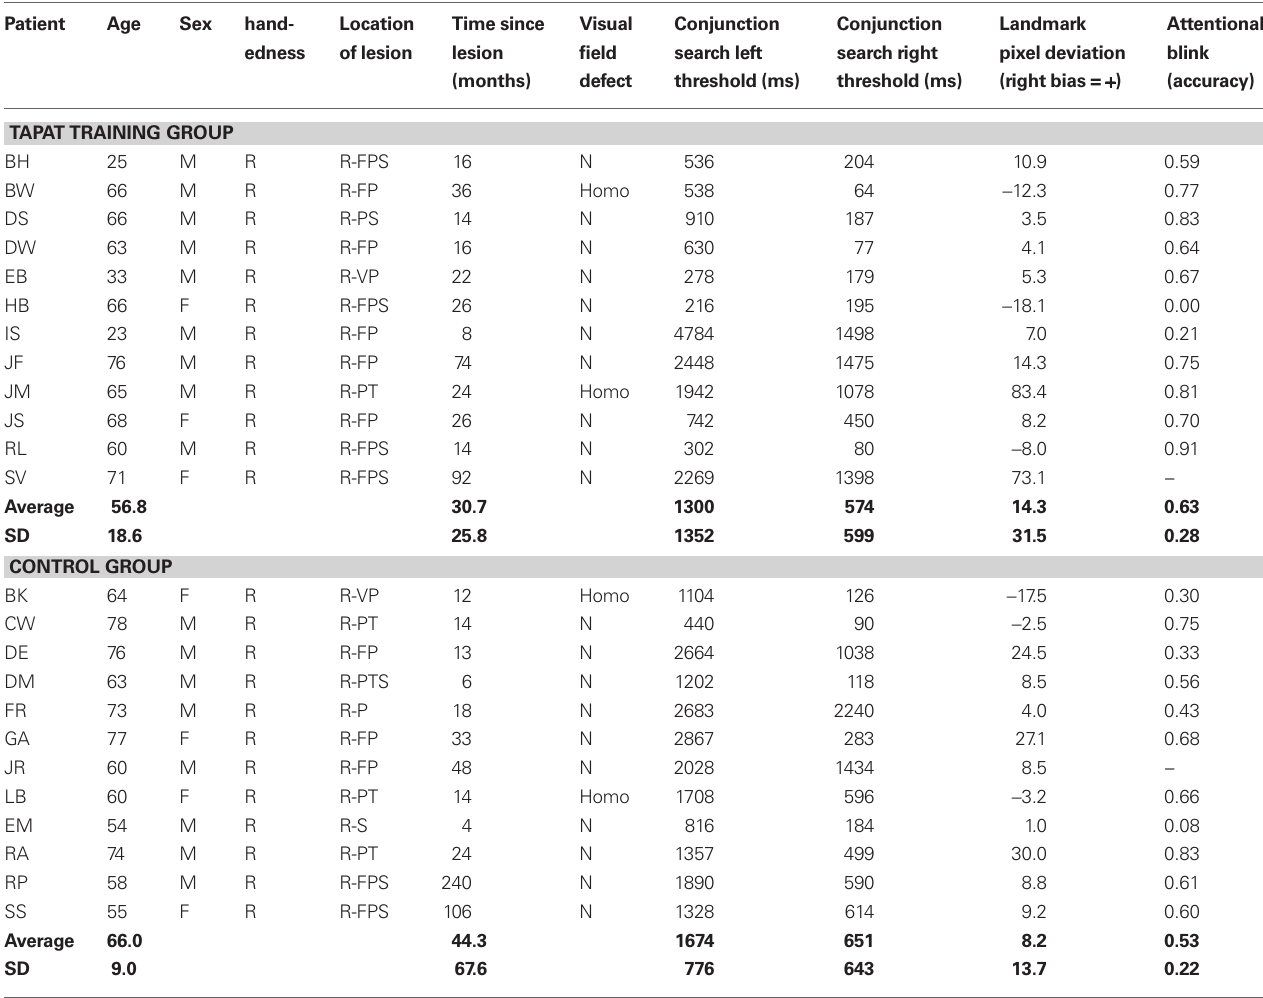
Table 1 | Profiles of patients in the tonic and phasic alertness training (TAPAT) group and control group.